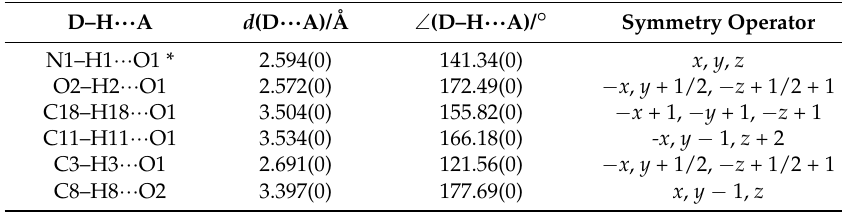
Table B4. Hydrogen bond geometry (Å, °) in compound mOHsaladpm .